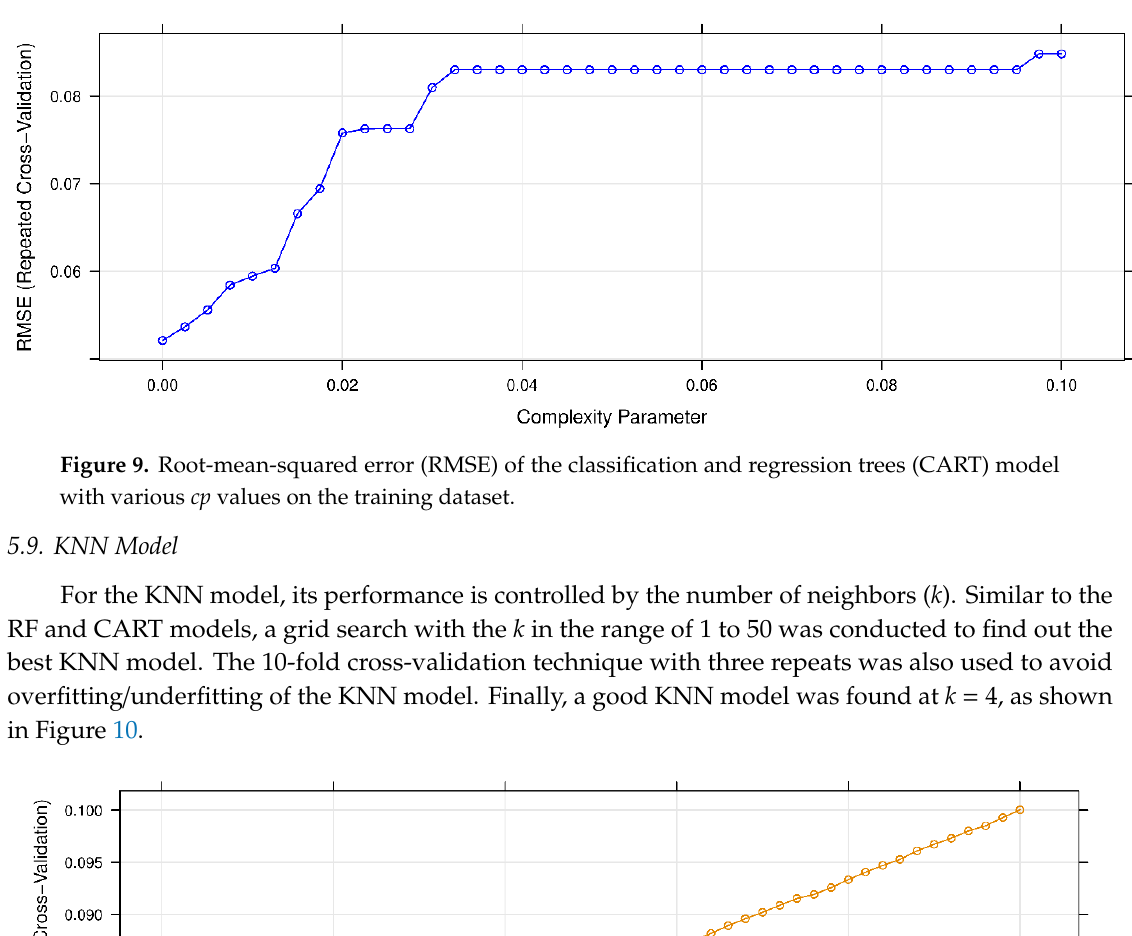
Figure 8. Performance of the random forest (RF) model for forecasting PM 10 concentration on the training dataset.